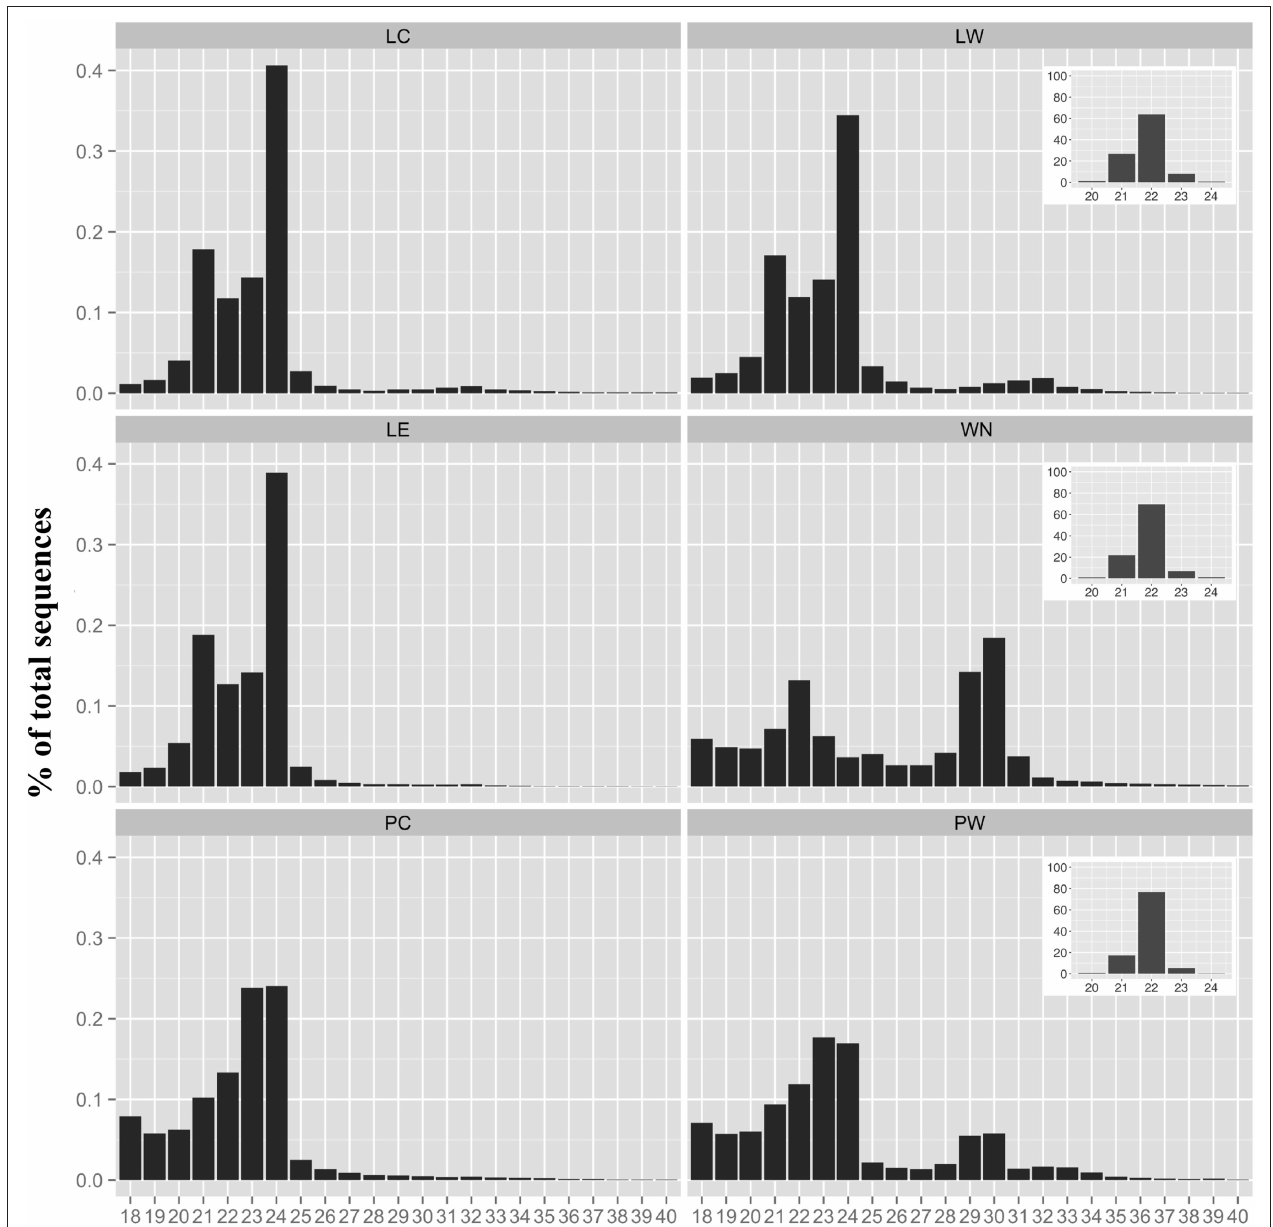
FIGURE 2 | Size distribution of sRNAs. Size distributions and percentages of small RNAs (sRNAs) between 18 and 40 nucleotides are indicated for each sample. LC, control leaflets (not infested with whitefly nymphs); LW, leaflets first infested with whiteflies but with adults and nymphs subsequently removed; LE, leaflets with whitefly eggs; WN, whitefly nymphs; PC, phloem control (not infested); PW, phloem infested with whitefly nymphs. Insets for LW, WN, and PW represent the size distributions and percentages of the sRNAs matching previously described whitefly miRNAs (Guo et al., 2013).